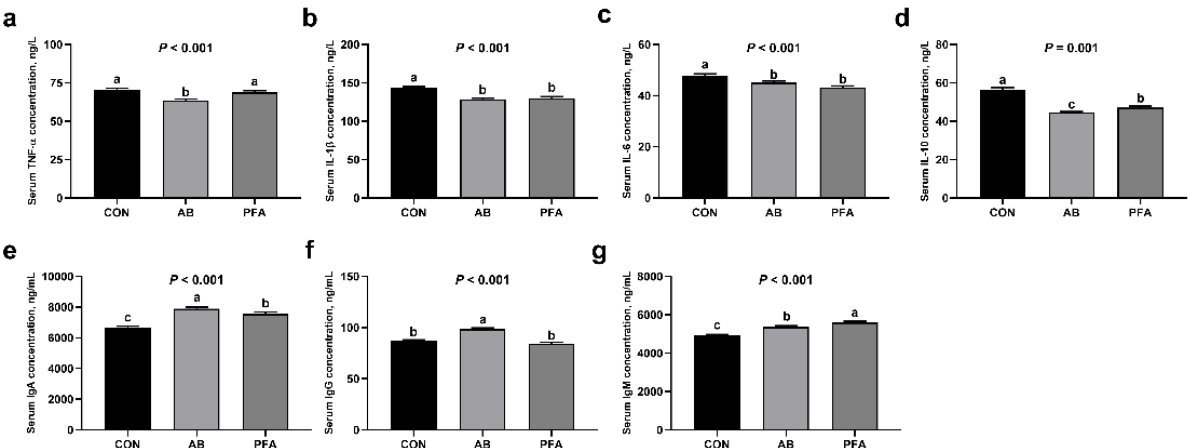
Figure 1. Effects of paraformic acid (PFA) supplementation on serum inflammatory cytokine and